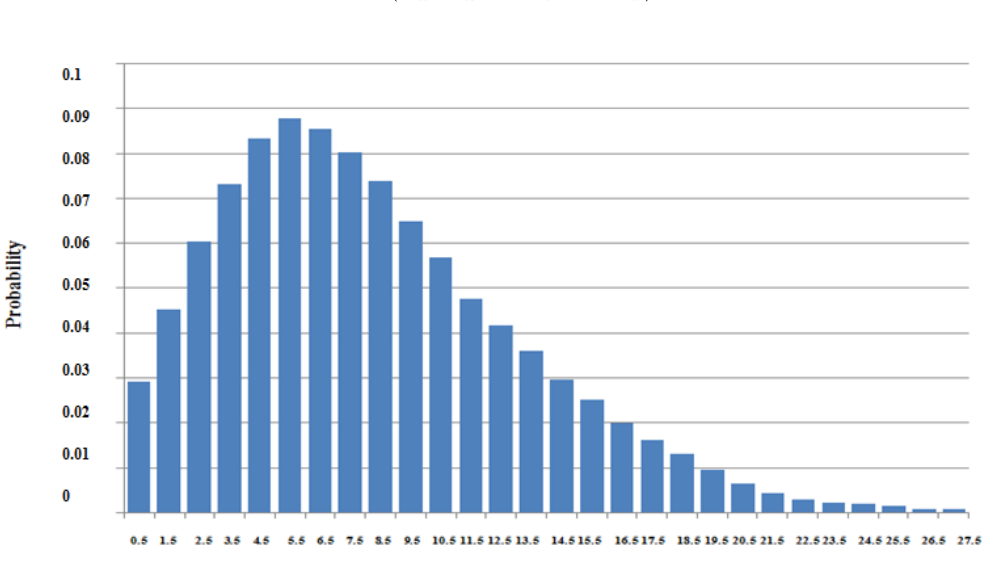
Figure 1. Output characteristic of a wind turbine in wind regime 2 (strong wind regime).